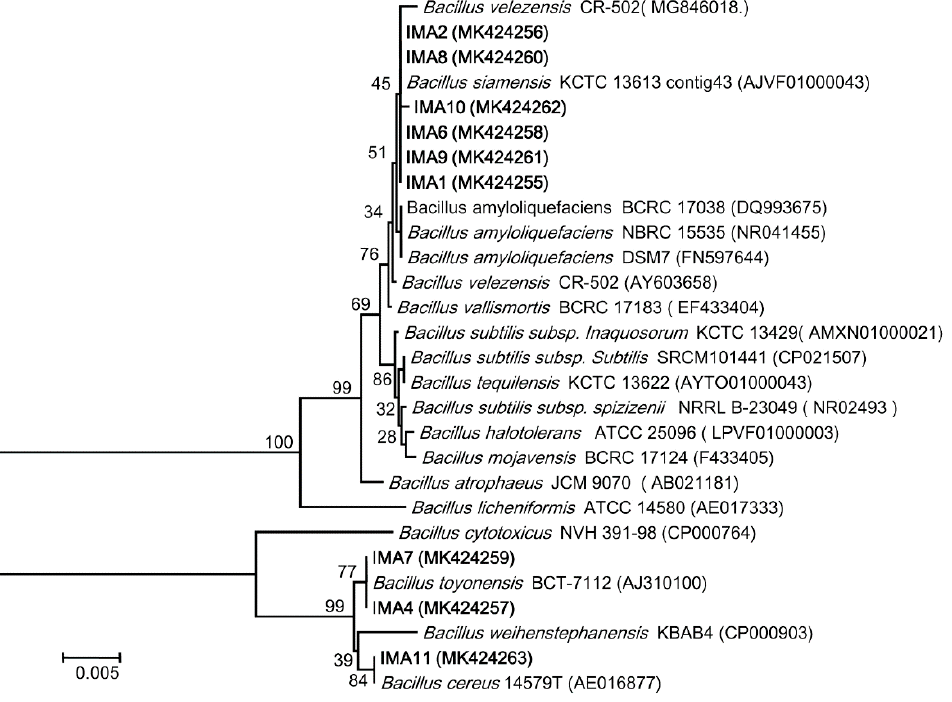
Figure 1. Phylogenetic tree generated from the neighbour-joining method from16S gene sequences of 28 taxa of Bacillus . Bootstrap values supporting the branches are shown at the nodes, and branch lengths are proportional to divergence. Strains isolated from rhizosphere soil of eggplant plants are shown in bold.